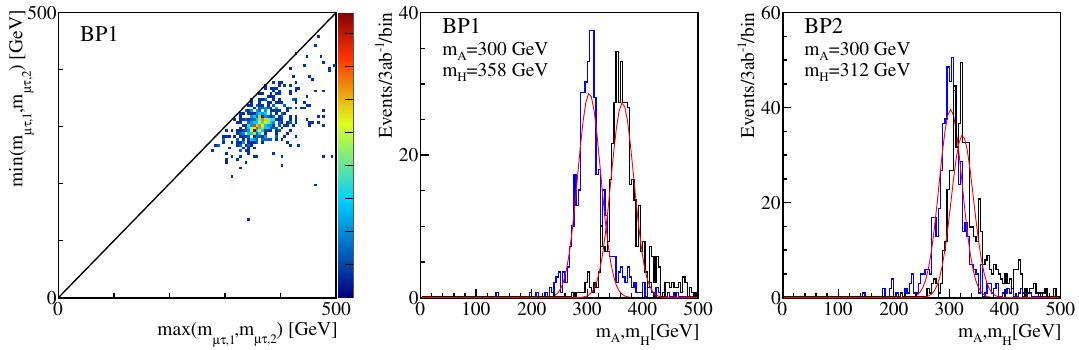
Figure 5 . The 2-dimensional m min regions are depicted in red points. Reconstructed m A and m H distributions for BP1 (center) and BP2